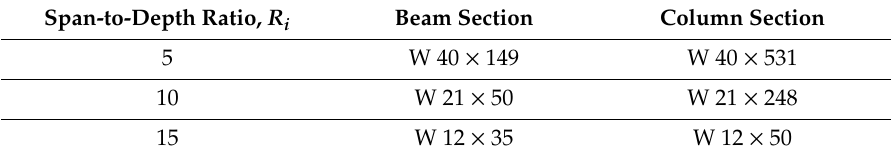
Table 1. Beam and Column Sections of the Steel Double-Span Assemblies (AISC Database). Span-to-Depth Ratio, R i Beam Section Column Section